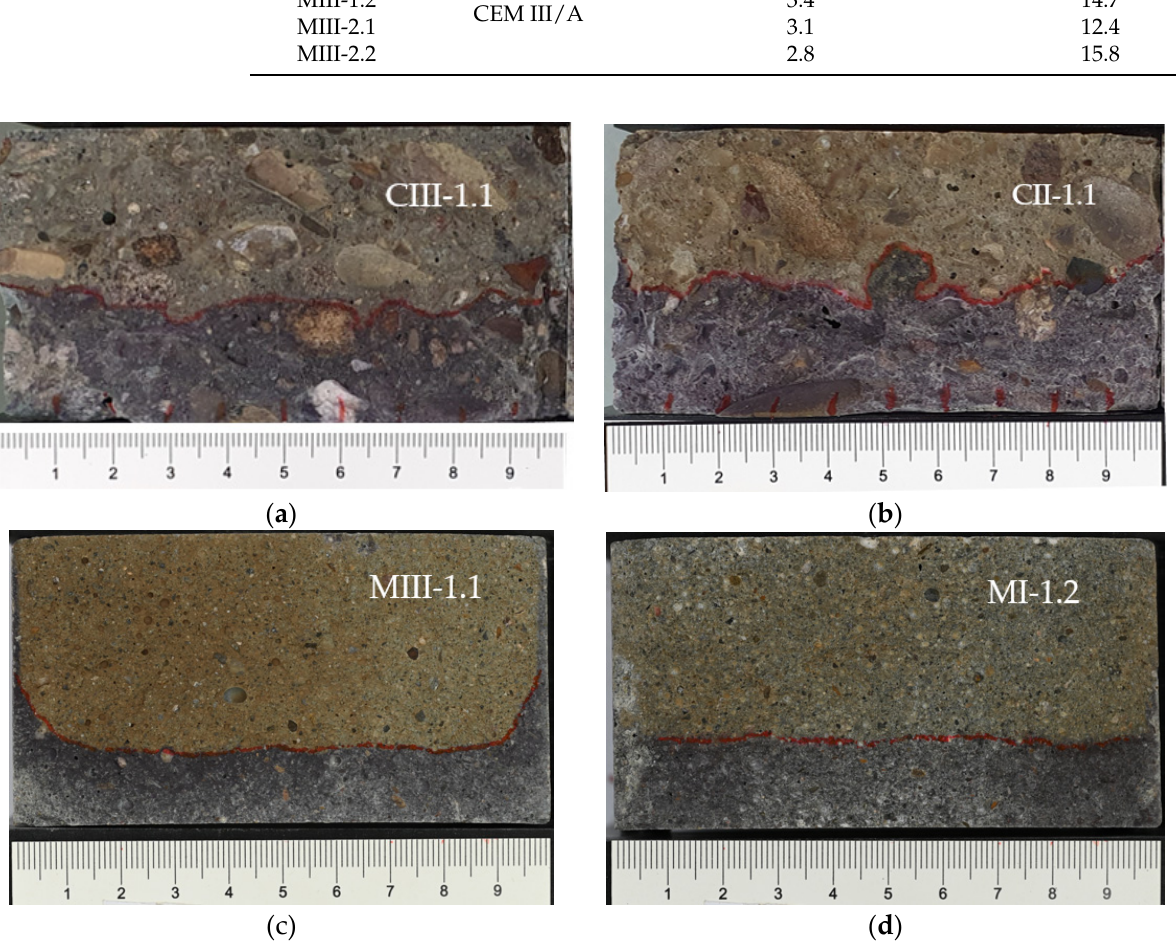
Figure 4. ( a ) Coloration of a CEM III/A specimen no. CIII-1.1 after AgNO 3 application. ( b ) Coloration of a CEM II/A-LL specimen no. CII-1.1 after AgNO 3 application. ( c ) Coloration of a CEM III/A specimen no. MIII-1.1 after AgNO 3 application. ( d ) Coloration of a CEM I specimen no. MI-1.2 after AgNO 3 application.